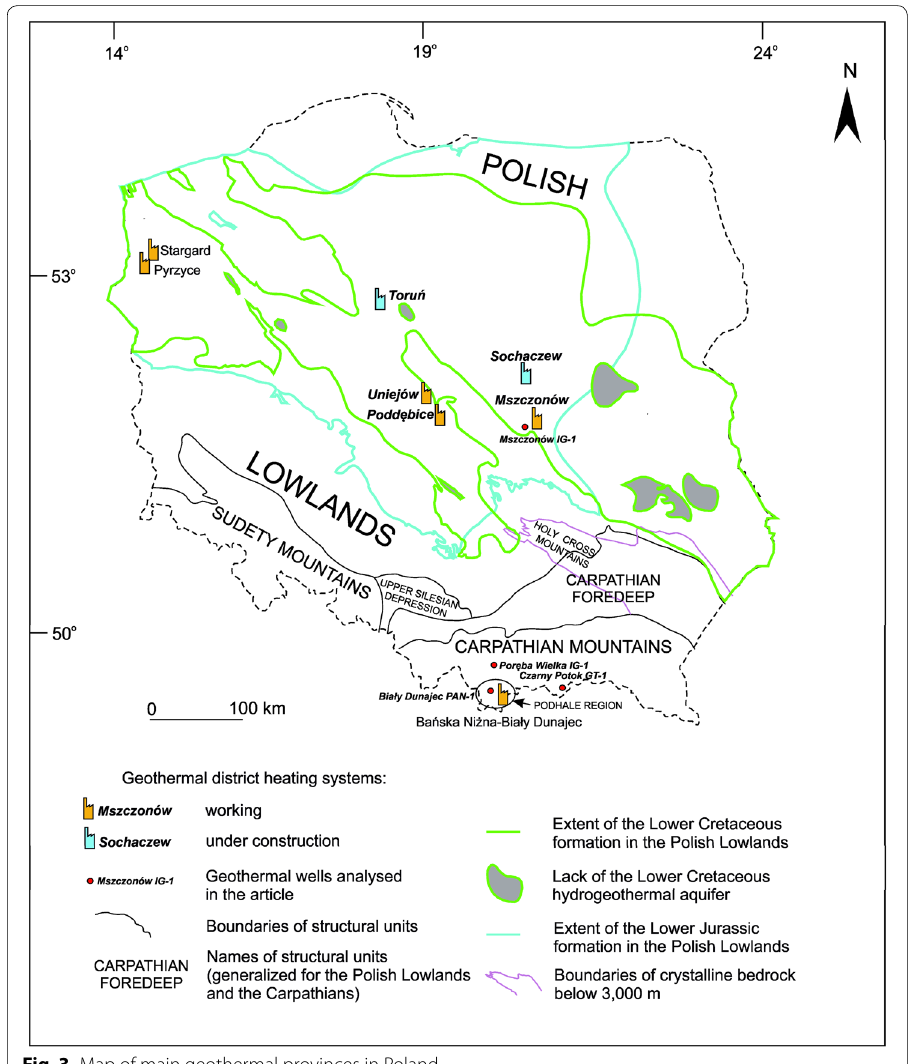
Fig. 3 Map of main geothermal provinces in